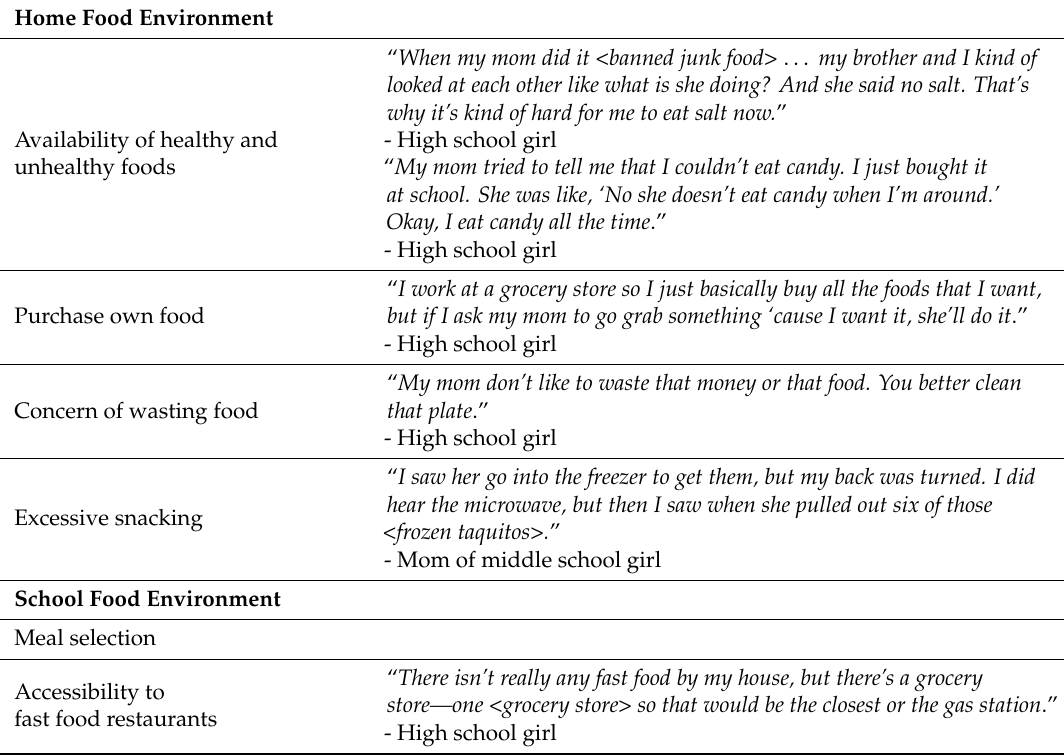
Table 2. Supporting quotes for factors in the home and school environments that influence food